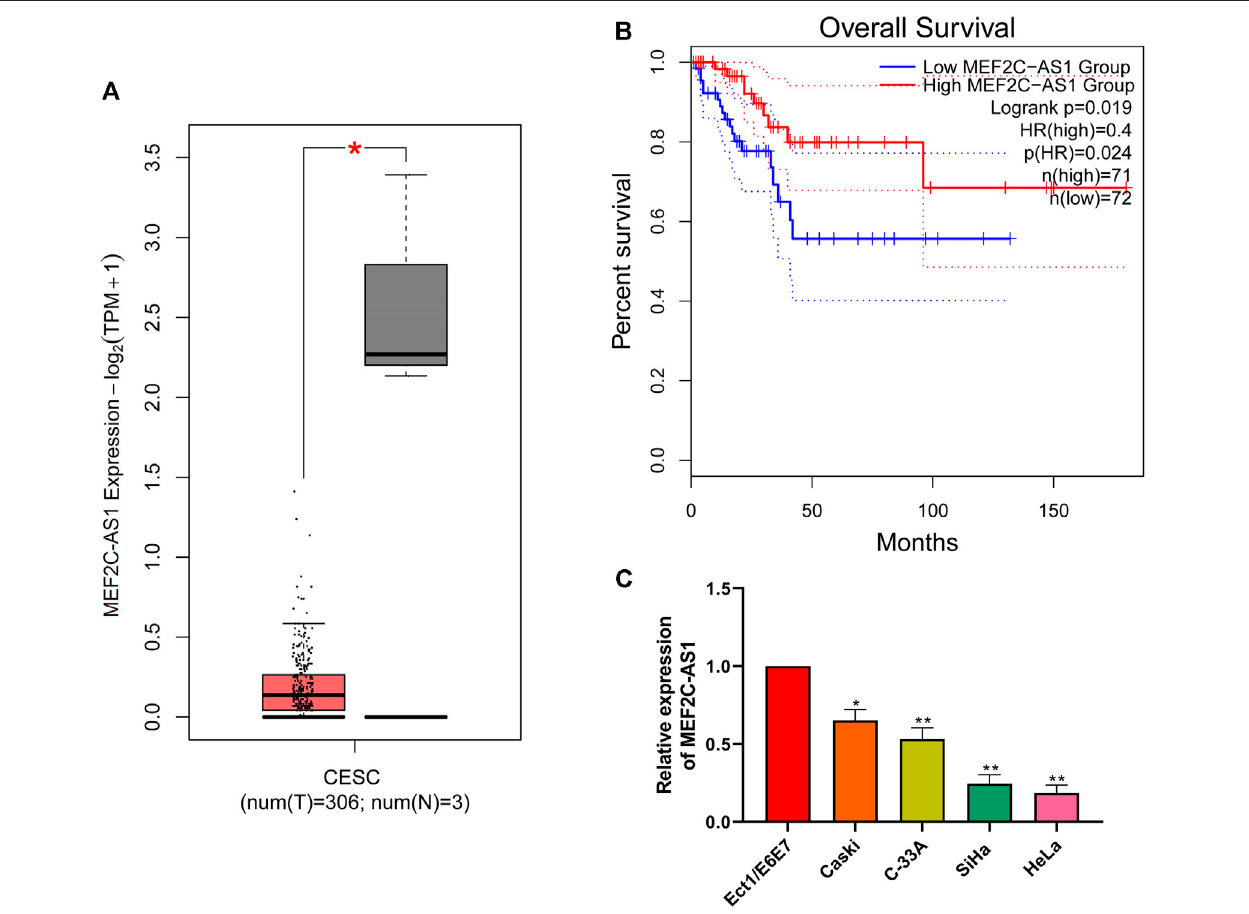
FIGURE 1 | LncRNA MEF2C-AS1 was low expressed in CC. (A) The expression of lncRNA MEF2C-AS1 in CC tissues compared with the normal tissues in the GEPIA website; (B) The prognosis of CC individuals provided the GEPIA dataset (the criteria of two groups was Quartile); (C) qRT-PCR was performed to detect the lncRNAMEF2C-AS1 expression incervicalcancercelllines (Caski, C-33A, SiHa, and HeLa)and normalcervicalcell(Ect1/E6E7). Measurementdatawereexpressed as mean ± standarddeviation.Thecellexperimentisrepeatedthreetimesindependently.* p < 0.05comparedwithnormaltissues (A) ;* p < 0.05,** p < 0.01,compared with Ect1/E6E7 group (C)